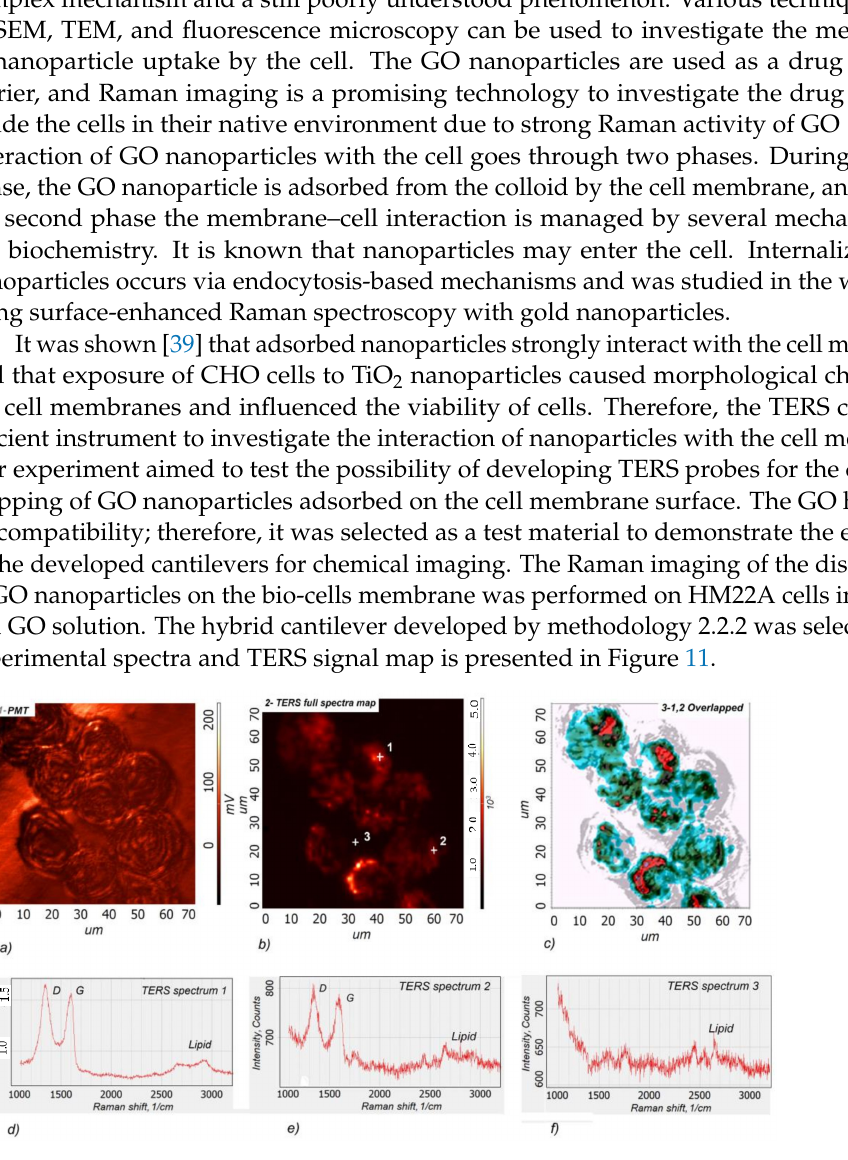
Figure 11. Scanning laser microscopy image of mouse hepatoma MH-22A cells with adsorbed GO nanoparticles. ( a ), AFM-based TERS chemical imaging map of GO full spectra (1000–3200 cm − 1 ) 1.0